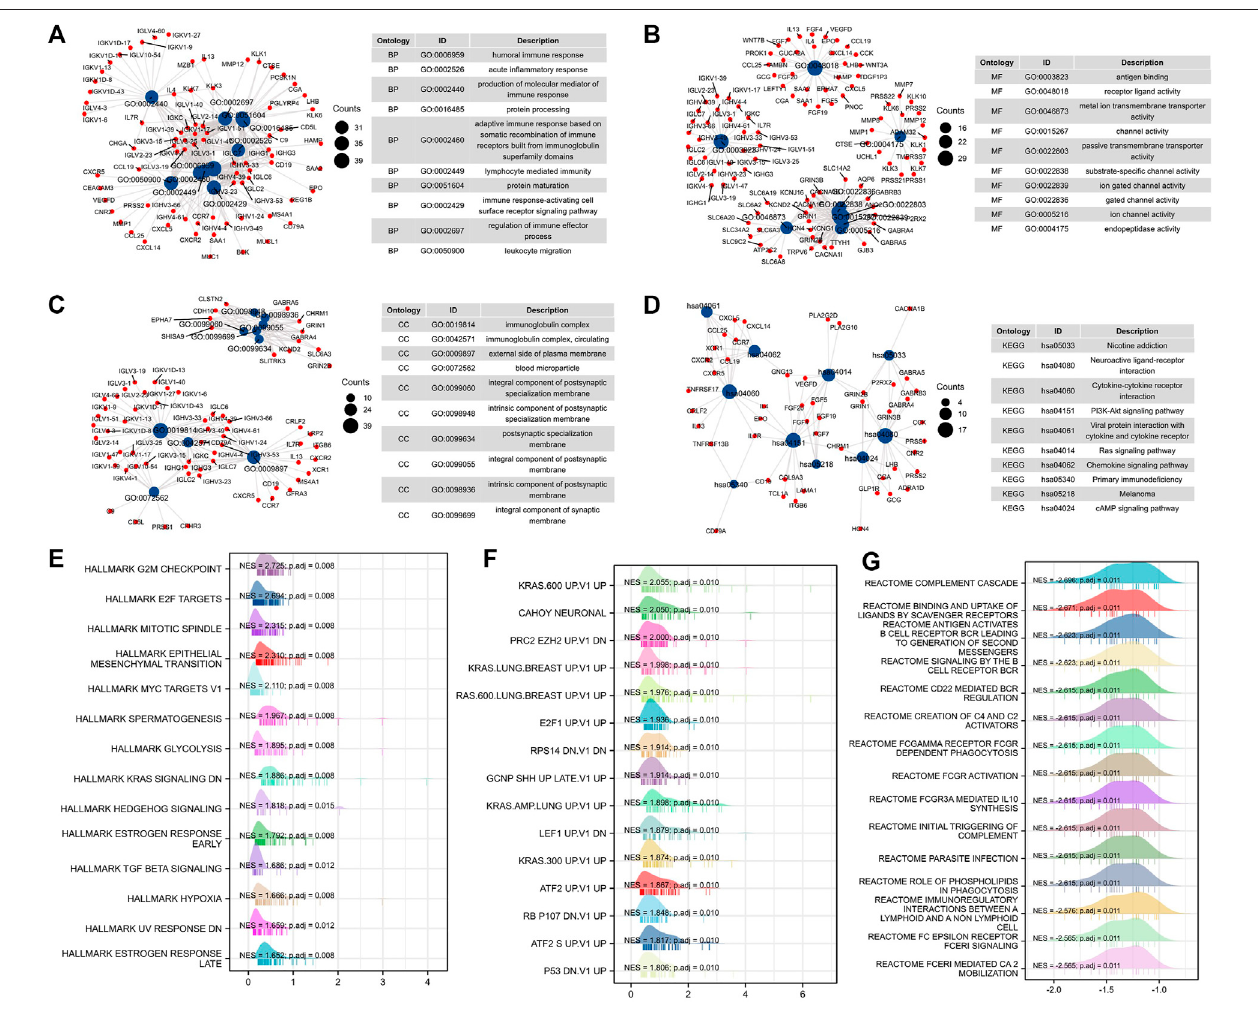
FIGURE 8 | Functional enrichment analysis of PRPF19-related genes (TCGA-LIHC). (A – D) Gene ontology analyses, including biological process, molecular function, and cellular component were performed by clusterPro fi ler R package. The size of each blue spot represents the gene number represented by this term, while the red spot represents the PRPF19-related genes. Gene set enrichment analysis of PRPF19-related genes in oncology and immunology. Top 15 annotation entries of three gene sets were drawn as wave graph. (E) Hallmarker results of PRPF19 GSEA in LIHC. (F) Oncogenic signature results of PRPF19 GSEA in LIHC. (G) Reactome results of PRPF19 GSEA in LIHC. NES, normalized enrichment score. p.adj, adjusted p value.